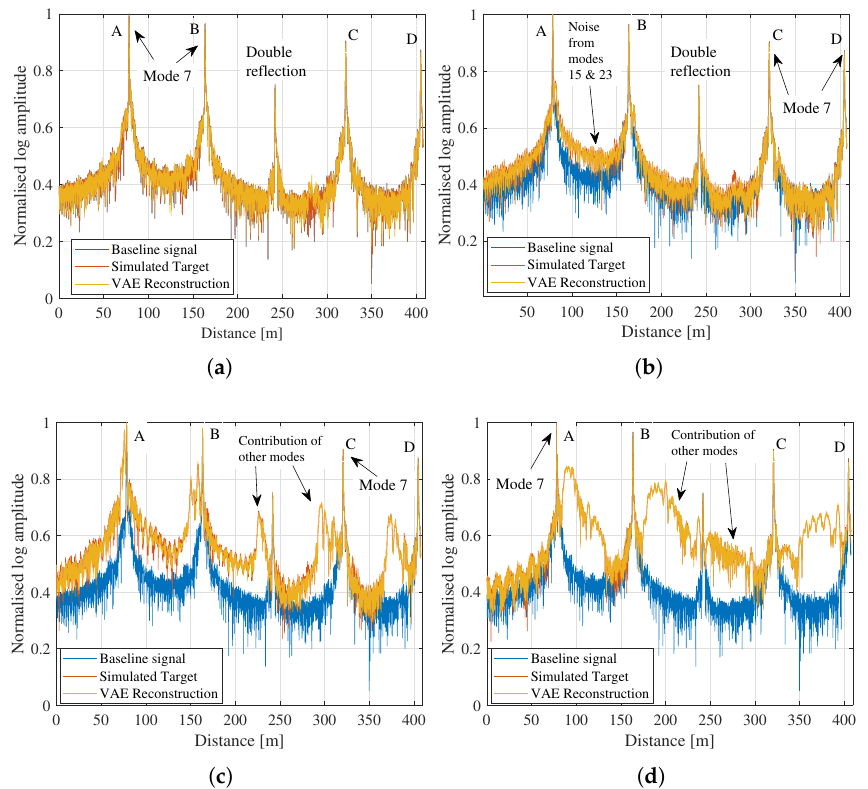
Figure 7. Response signals reconstructed using a VAE compared to the original target response for different mode combinations. ( a ) Modes {7, 9, 11}, ( b ) Modes {7, 15, 23}, ( c ) Modes {7, 8, 15, 21, 22, 23} and ( d ) Modes {7, 16, 24}.